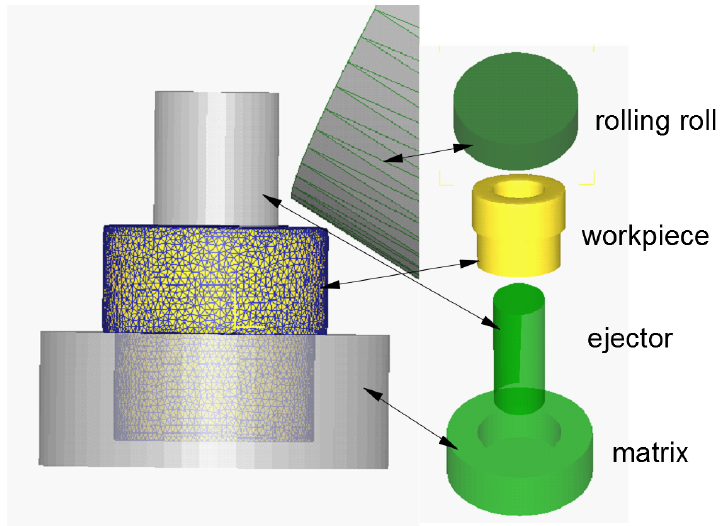
Figure 4. Finite element (FE) simulation of the cold angular rolling of a flange part.